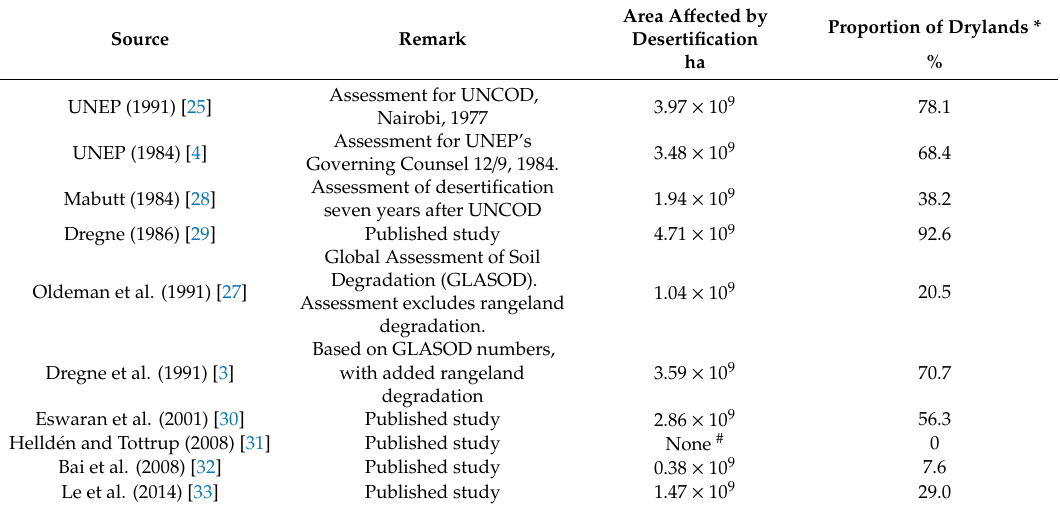
Table 1. Reported assessments of the extent of desertification in the global